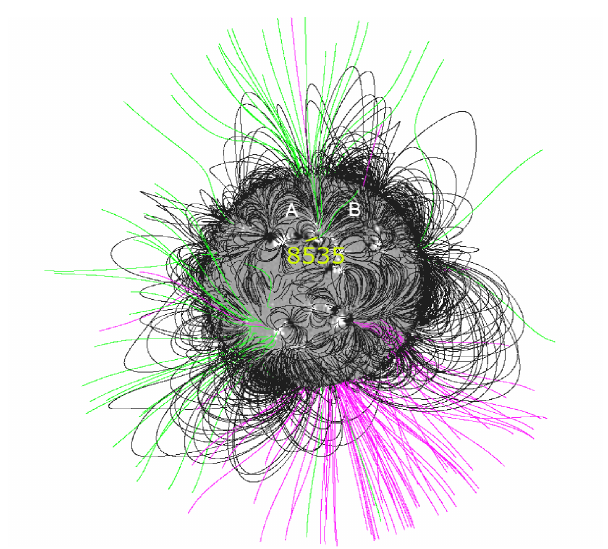
Fig. 7. Magnetic field lines of the “haired” Sun for the Carrington rotation number 1949 calculated with the PFSS model under R SS = 2 . 5 R (cid:12) . The open field lines to the north of the sunspot 8535 (green color) parting the photospheric footpoints of the strongly diverging loops of the same magnetic polarity in two arcades, “A” and “B” (field lines of black color). This open-field region is further denoted as the